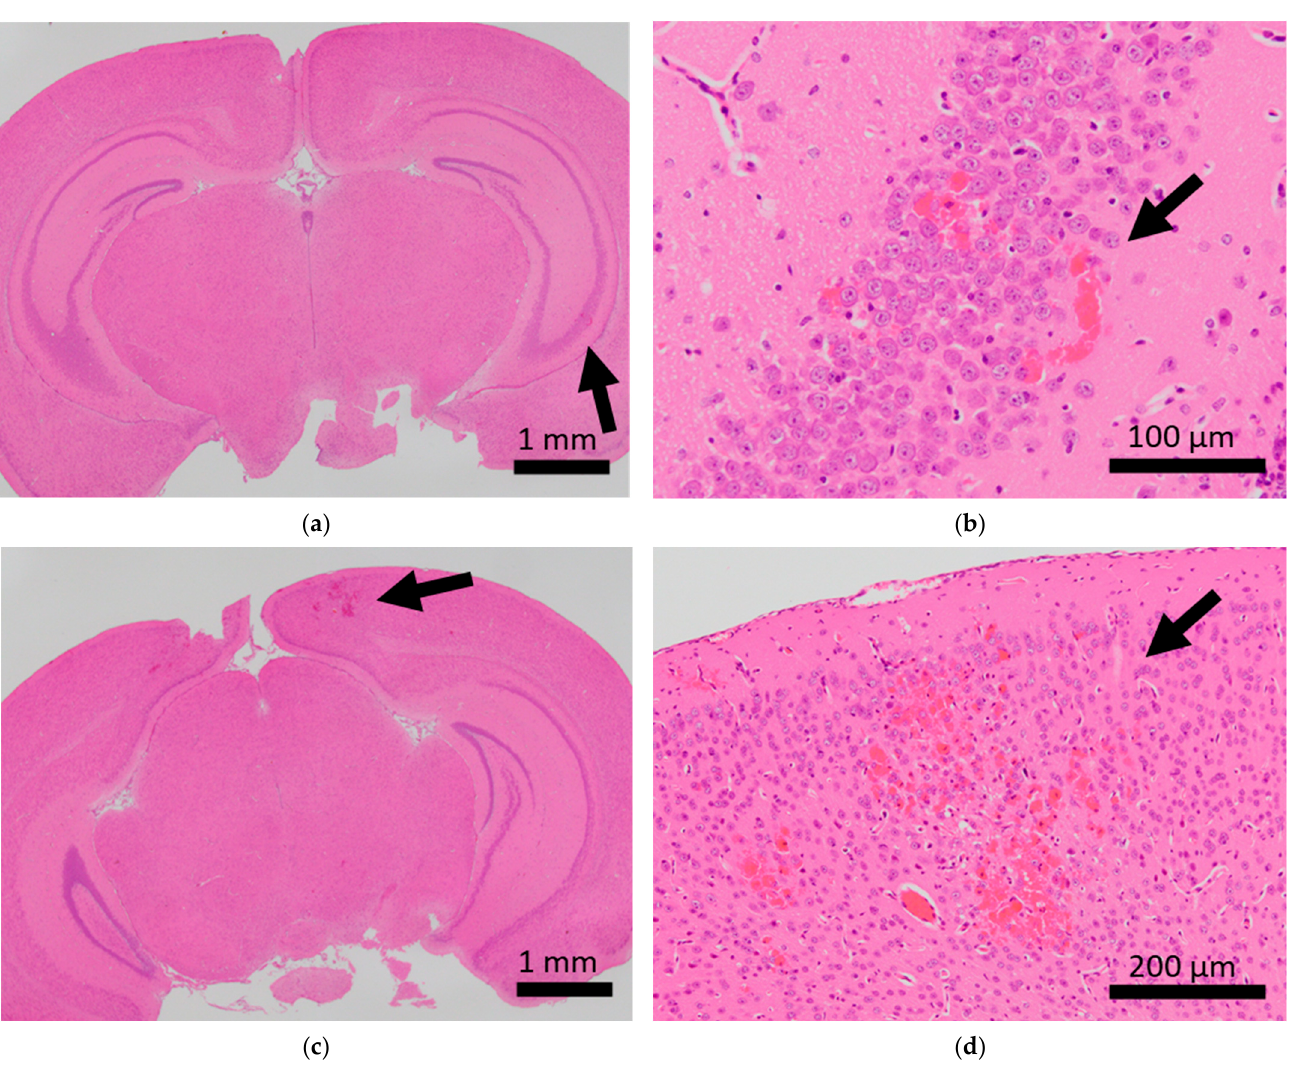
Figure 1. Histopathological analysis of the brains of BALB/c mice. Arrows indicate microhemor- rhage in the brains of mice exposed to sCSDS. ( a , b ) Hippocampal microhemorrhage; ( c , d ) cerebral microhemorrhage.